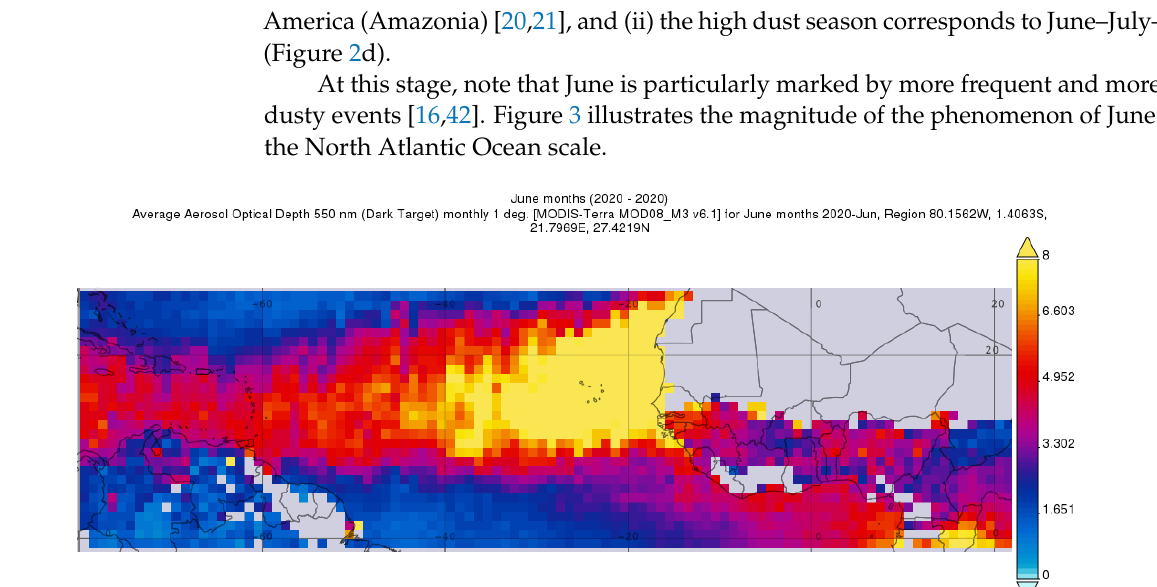
Figure 3. MODIS satellite image of the North Atlantic area with AOD values for the extreme event of June 2020. (NASA GIOVANNI (https://giovanni.gsfc.nasa.gov/giovanni/) (accessed on 20 January